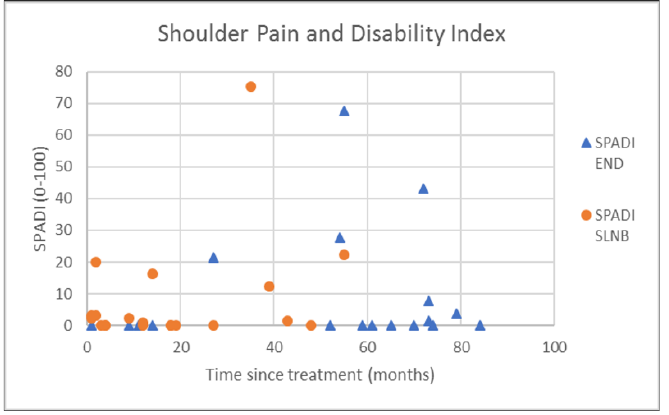
Figure 1. Shoulder disability questionnaire (SDQ) in relation to time since treatment .